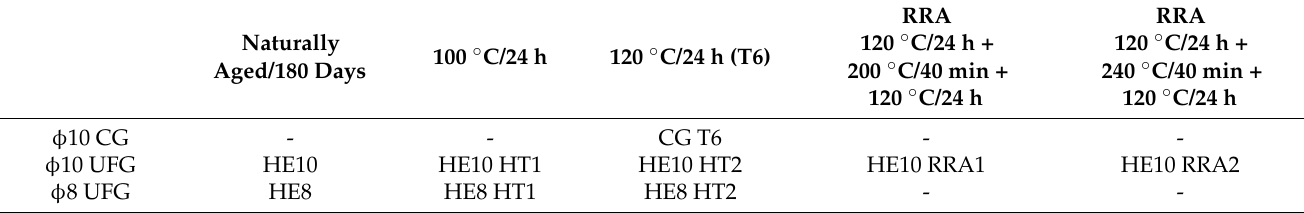
Table 2. Sample designations with respect to the applied heat